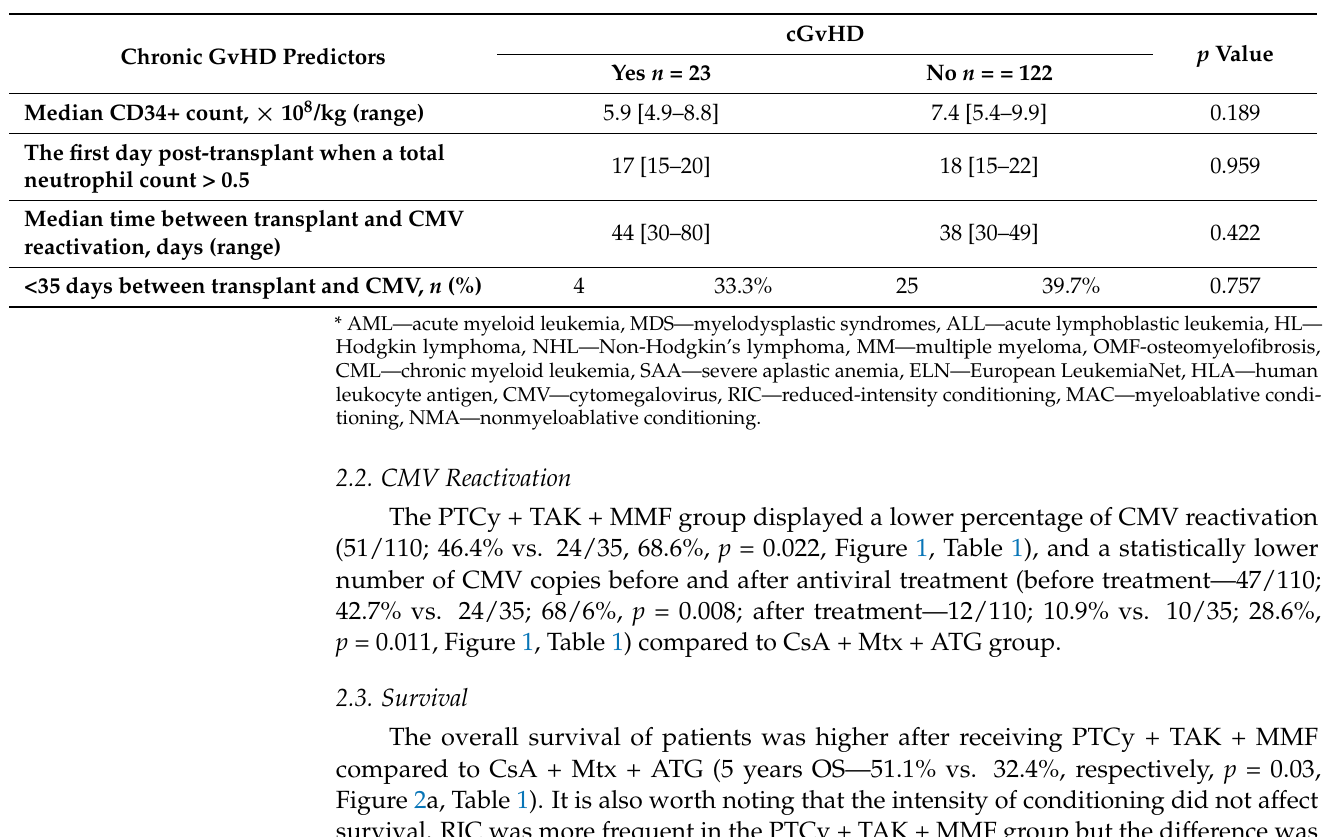
Figure 2. Kaplan–Meier curves for : ( a ) OS (overall survival), ( b ) aGvHD incidence, ( c ) NRM (nonre- lapse mortality), ( d ) PFS (progression - free survival) . 3. Discussion In cases of lack of HLA - identical siblings or unrelated donors, alternative strategies rely on haploidentical donors, mismatched unrelated donors (MMUDs), and unrelated cord blood units. However, these options have been found to be more tricky, particularly by the increased incidence of graft - versus - host diseases (GvHD) and nonrelapse mortality (NRM) [21 – 23]. Strategies aiming to improve GvHD prophylaxis have already been well introduced. For many years, the standard curative therapy was the use of in vivo T - cell depleting agents such as antithymocyte globulin (ATG) or alemtuzumab, in association w ith a calcineurin inhibitor and methotrexate or mycophenolate mofetil [24]. However, based on the revolutionizing study at John Hopkins, more attention to post - transplant cyclophosphamide in the haplo - HSCT setting has been paid, with significant improve- ments in GvHD and NRM rates, and engraftment as well [9]. More recently, several stud- ies tested the use of these immunosuppressive agents in other transplantation settings, including MMUD - HSCT [16,19,25,26]. Therefore, although PTCs are not standard agents routinely used in MMUD - HSCT, future studies should attempt to optimize protocols for MMUD - HSCT. The current study compared two groups classified by different immunosuppression methods including post - transplant cyclophosphamide (PTCy), in combination with tac- rolimus (TAK) , and mycophenolate mofetil (MMF) and cyclosporine (CsA), methotrexate (MTX), and anti - thymocyte globulin (ATG). Among patients receiving PTCy + TAK + MMF, 93 underwent haplo - HSCT (93/110; 84.5%) and 17 underwent MMUD - HSCT (17/110; 15.5%, Table 1). By analyzing these study groups, we could determine which im- munosuppressive agents were more effective for different transplantation settings. Con- sistent with several studies [1,2,7,11], our results indicated a more favorable use of post -